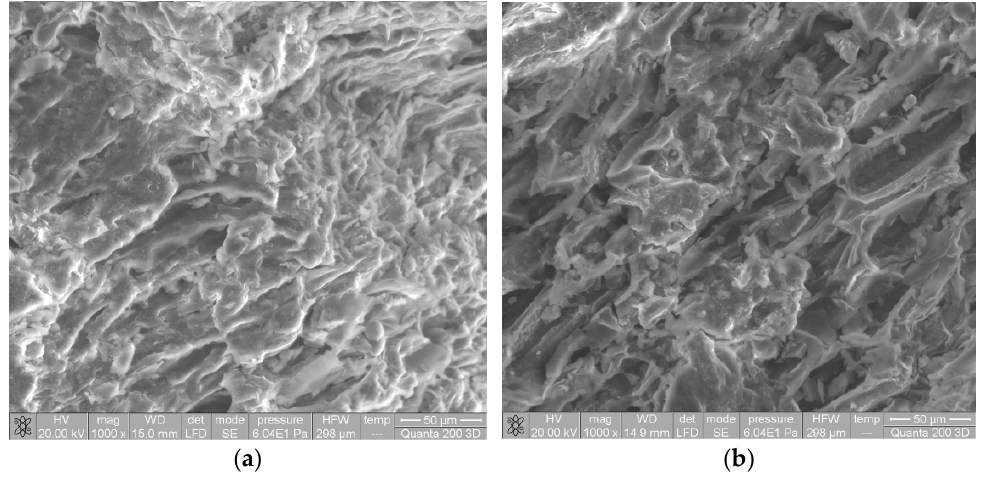
Figure 2. SEM images of soy waste biomass before ( a ) and after ( b ) alkaline